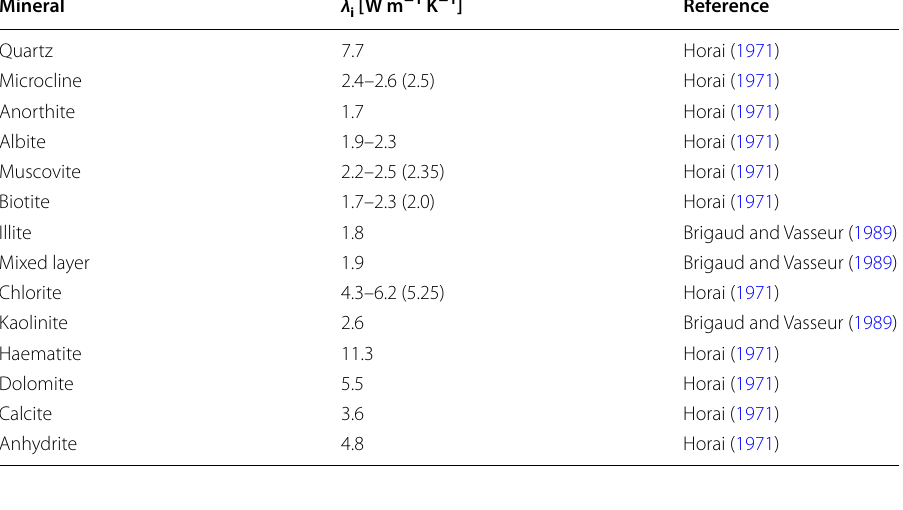
of selected mineral phases applied in this study i